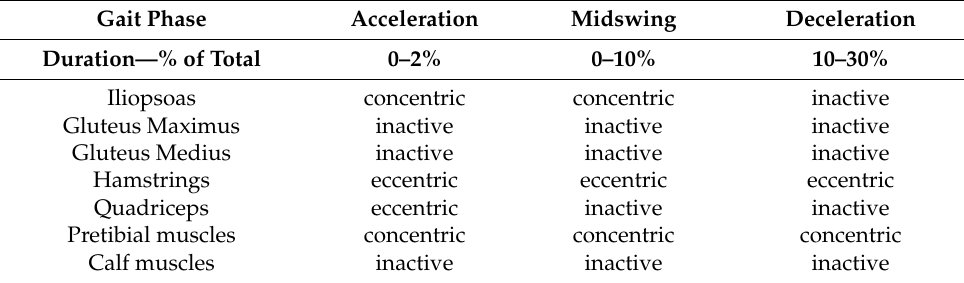
Table 2. Muscular activity throughout the swing phases of the gait cycle